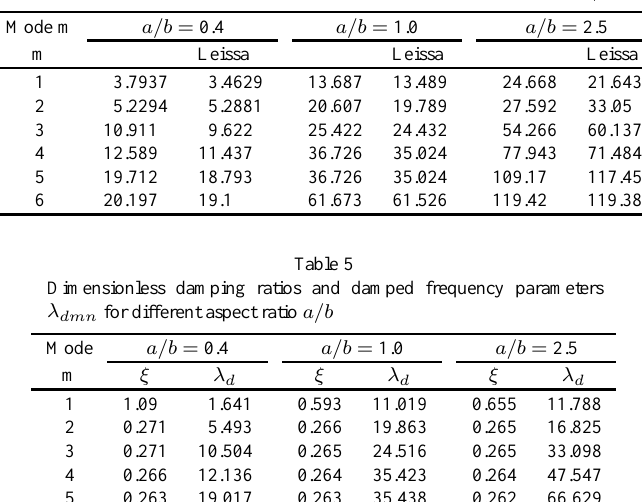
Table 4 Dimensionless frequency parameters λ mn for different aspect ratio a/b